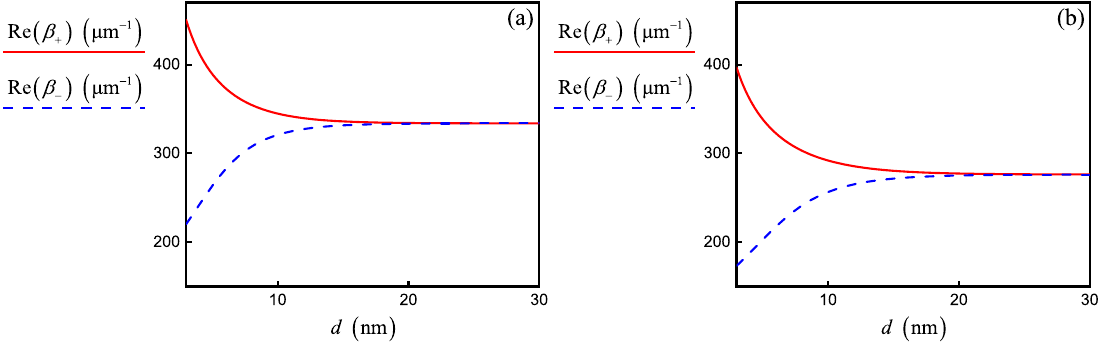
Figure 4. Propagation constants β + (solid red lines) and β − (dashed blue lines) for SPP modes in the double-layer graphene sheets versus the interlayer distance d ( a ) with and ( b ) without taking into account the interband conductivity of graphene calculated by using the analytical solutions of Equation (12). Parameters correspond to a weak coupling regime for wavelength 2.56 µm in Table